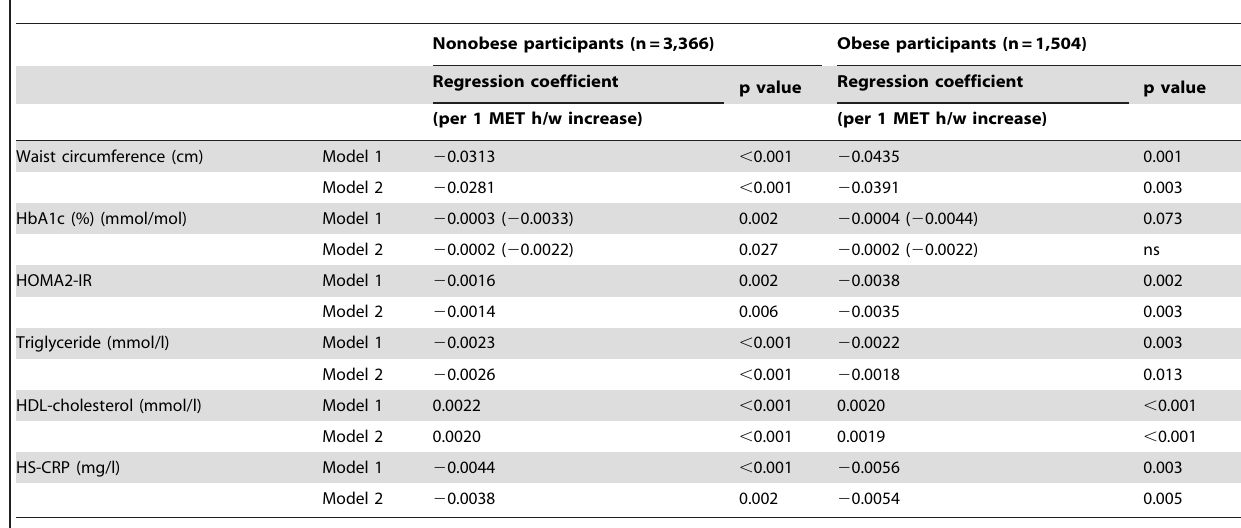
Table 2. Multiple regression analysis of T-LTPA with metabolic and inflammatory variables in non-obese and obese